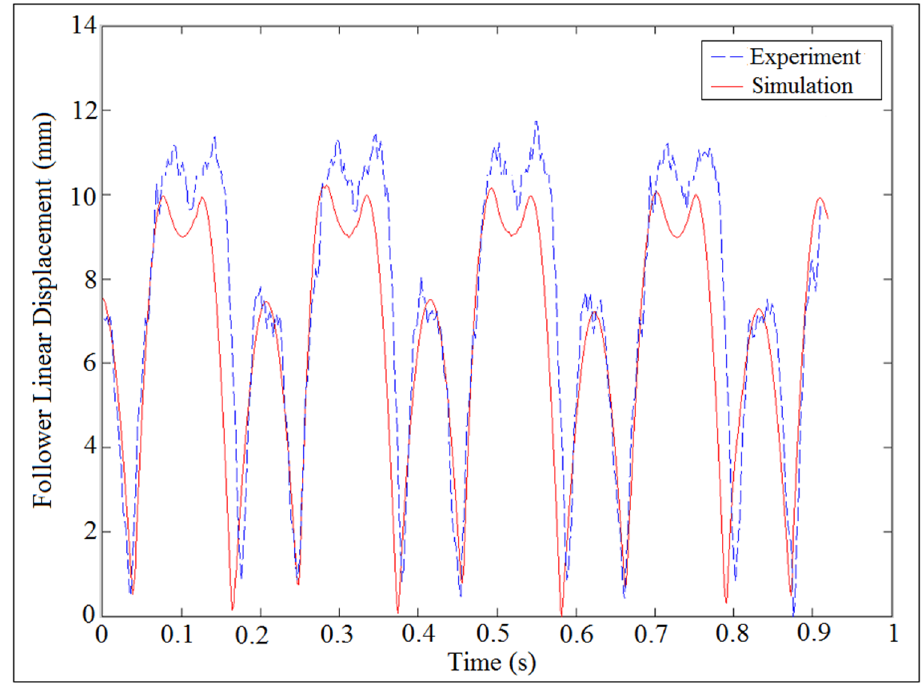
Figure 38. Comparison of follower linear displacement against time.